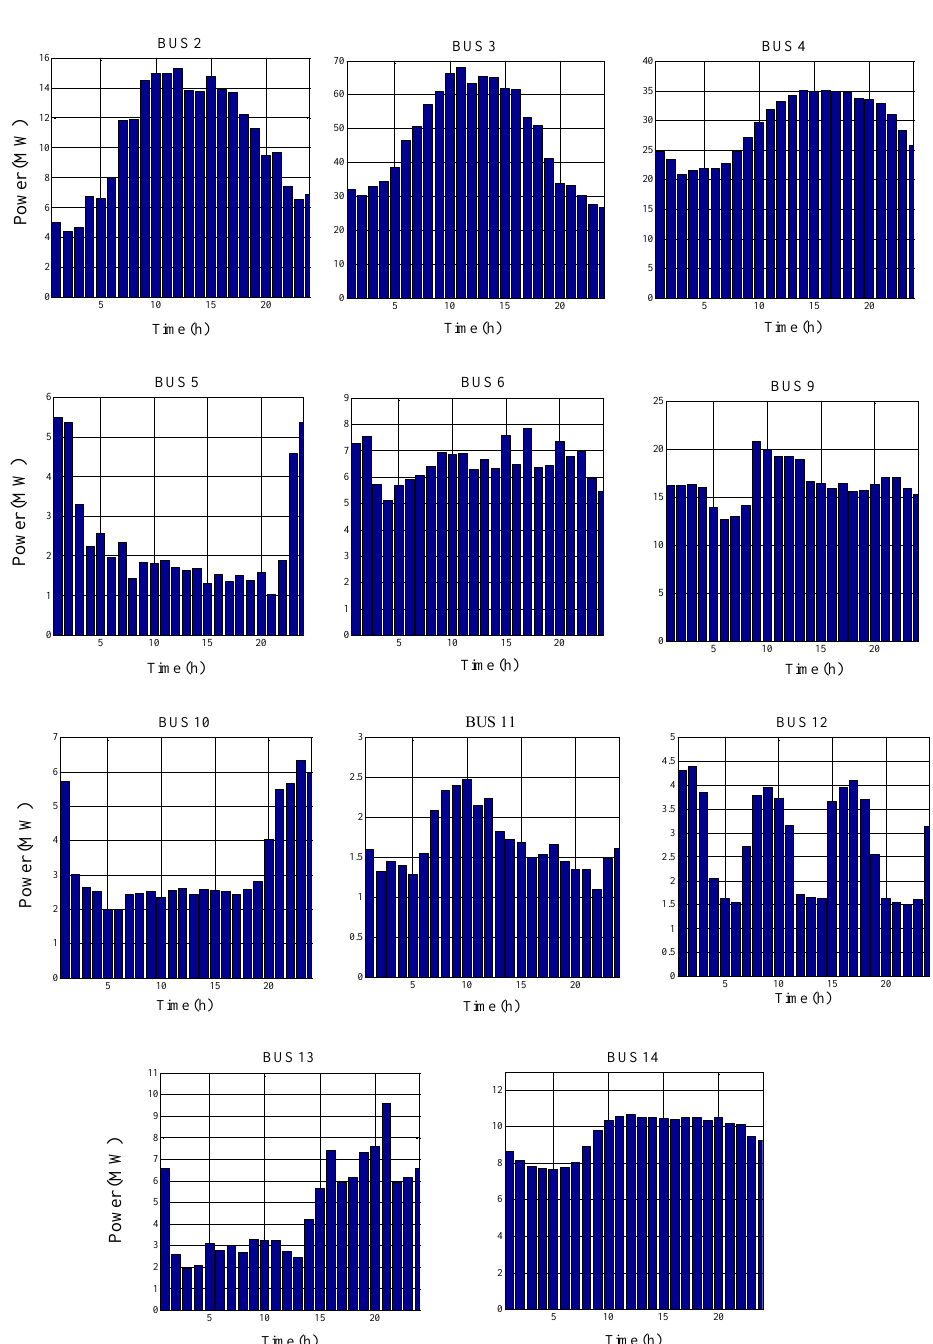
Figure 12. Case 2: testing loads for the VPP system, including the IEEE 14-bus test system.